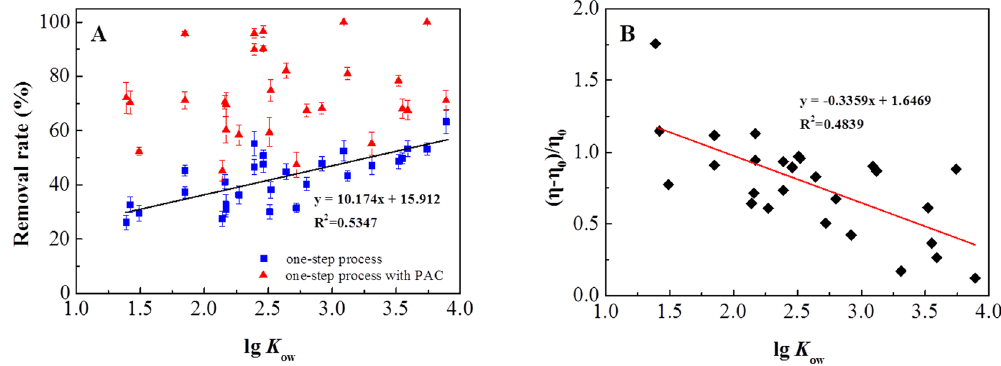
Figure 8. Relation between removal rate of the processes. ( A ) PAC enhancement, ( B ) lg K ow of aromatic organics. Bentonite dose: 0.5 g L − 1 , CTMAB dose: 60% CEC, PAC dose: 0.5 g L − 1 . Error bars represent standard deviations (n =